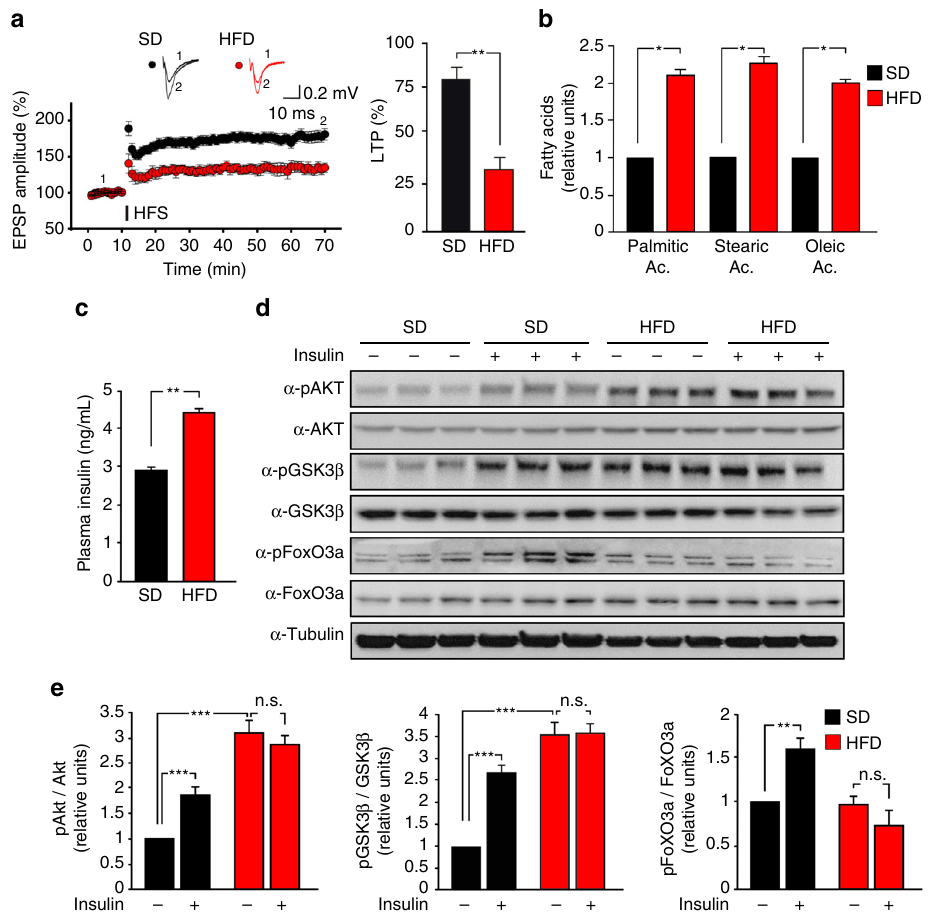
Fig. 1 HFD impairs synaptic plasticity, induces insulin resistance, and increases palmitic acid levels in the hippocampus. a Time course of LTP at CA3-CA1 synapses induced by HFS delivered at time 10 (line) in hippocampal slices obtained from mice fed with SD ( n = 12 slices) or HFD ( n = 9 slices) for 6 weeks. Results are expressed as percentages of baseline fEPSP amplitude ( = 100%). Insets show representative fEPSPs at baseline (1) and during the last 5 min of LTP recording (2). Traces are averages of fi ve consecutive responses at the time points indicated with 1 and 2. On right, bar graphs of LTP observed during the last 5 min in SD and HFD mice (statistics by unpaired Student ’ s t- test). b Relative amounts of fatty acid (measured by GC-FID analysis) extracted from hippocampi of SD ( n = 9) and HFD ( n = 8) mice (statistics by unpaired Student ’ s t -test). c Insulin plasma levels of SD and HFD mice measured by ELISA performed in duplicate ( n = 10 mice per group; statistics by unpaired Student ’ s t- test). d Immunoblot analysis revealing increased phosphorylation of Akt Ser 473 and GSK3 β Ser 9 and abolished responsiveness to insulin injection in the hippocampi of HFD mice. Samples were harvested from two independent experiments. e Densitometry of phospho-proteins (shown in d ) normalized to both the corresponding total protein and tubulin ( n = 6 per group; statistics by two-way ANOVA and Bonferroni post hoc). Data are expressed as mean ± standard error of the mean (SEM). * p < 0.05; ** p < 0.01; *** p < 0.001; n.s. not signi fi cant. See also Supplementary Fig.